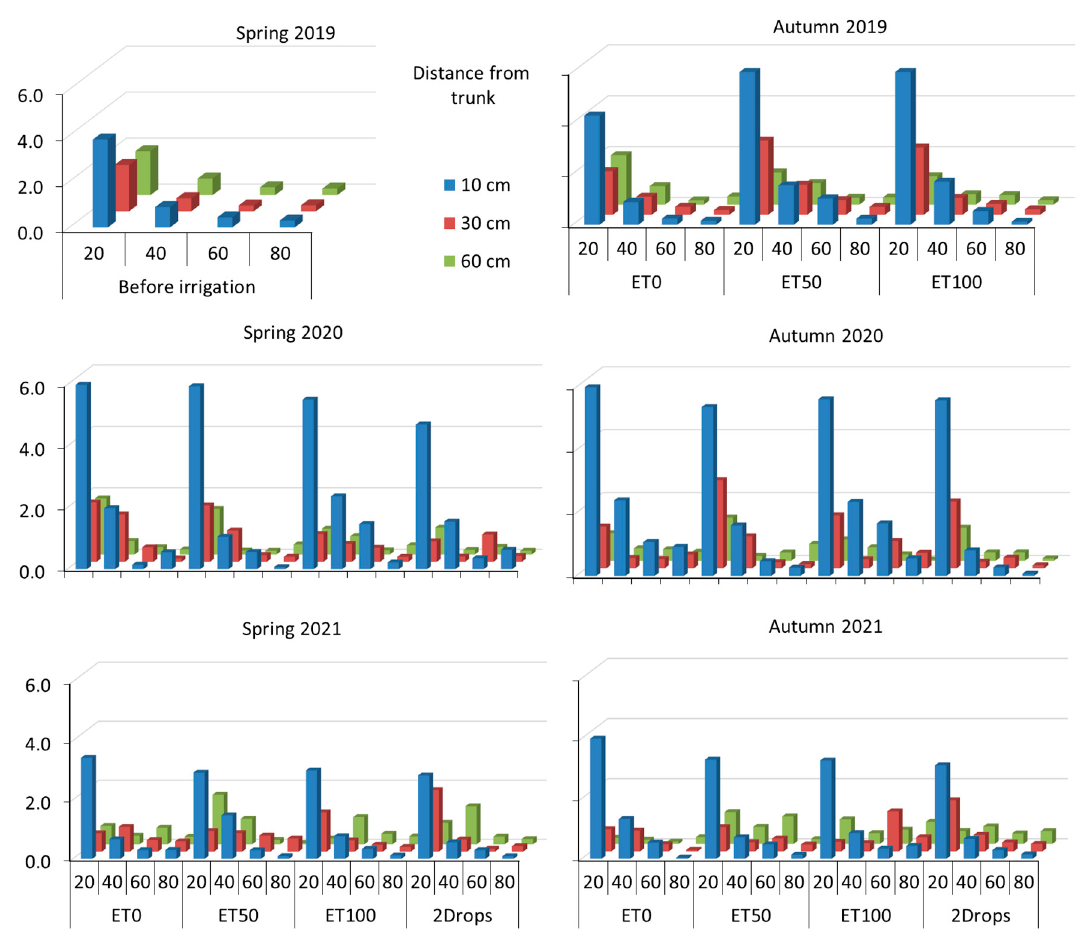
Figure 5. Distribution of all roots (RDt) in a soil profile to a depth of 80 cm at distances of 10 cm, 30 cm, and 60 cm from the trunk. ET0, ET50, ET100, and 2Drops refer to the variants—rain-fed control without irrigation, doses of 50% and 100% of calculated evapotranspiration, and a dose of 100% applied by two lines of irrigation hoses, respectively.